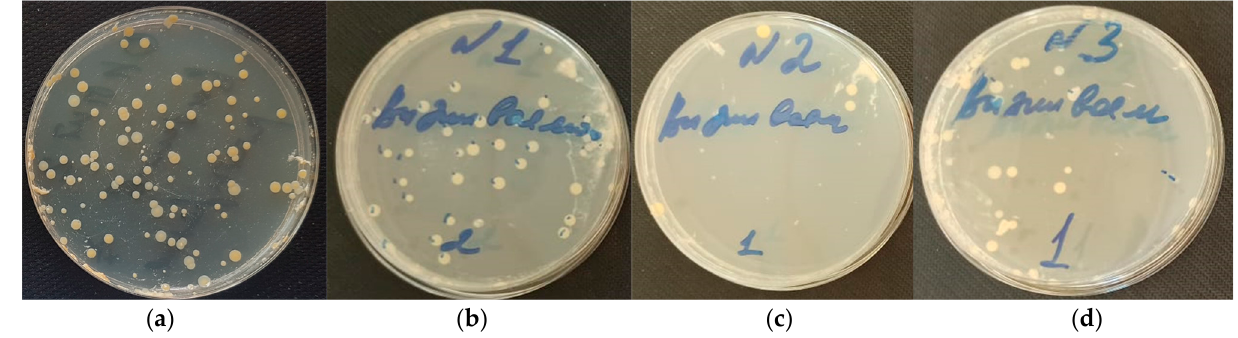
Figure 5. Photos of the “survival rate” of Staphylococcus aureus bacteria on matrices with different coatings. ( a ) Matrix without coating; ( b ) DND coating; ( c ) DND–Amikacin coating; ( d ) DND–Levofloxacin coating. Table 3. The adhesion index and the survival index of Staphylococcus aureus calculated according to the results of bactericidal efficacy for the DND, DND–Levofloxacin and DND–Amikacin.